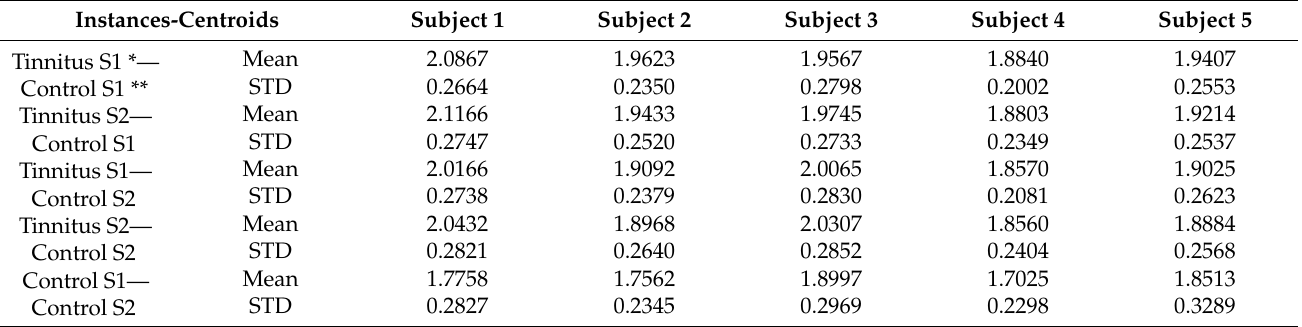
Table 8. Distance measures among data instances of control and tinnitus groups and control